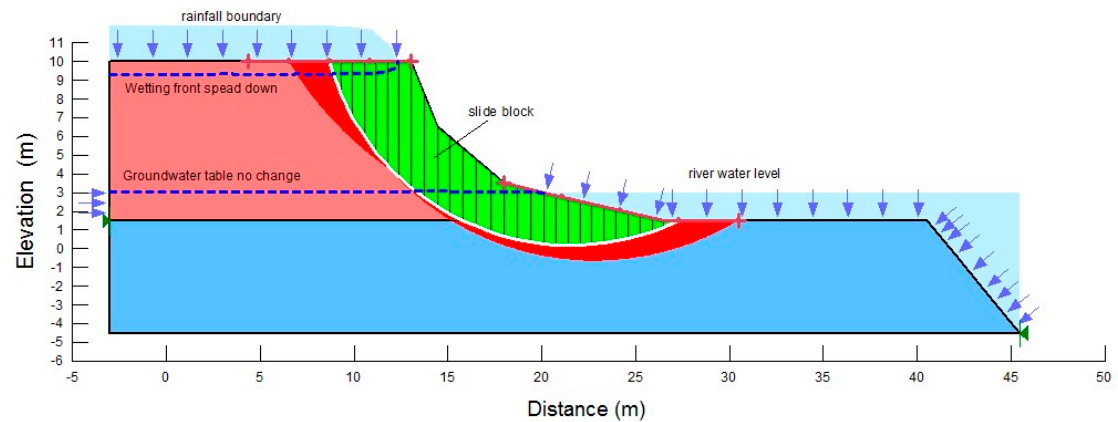
Figure 12. The wetting front descending when the RI is much higher than HC.